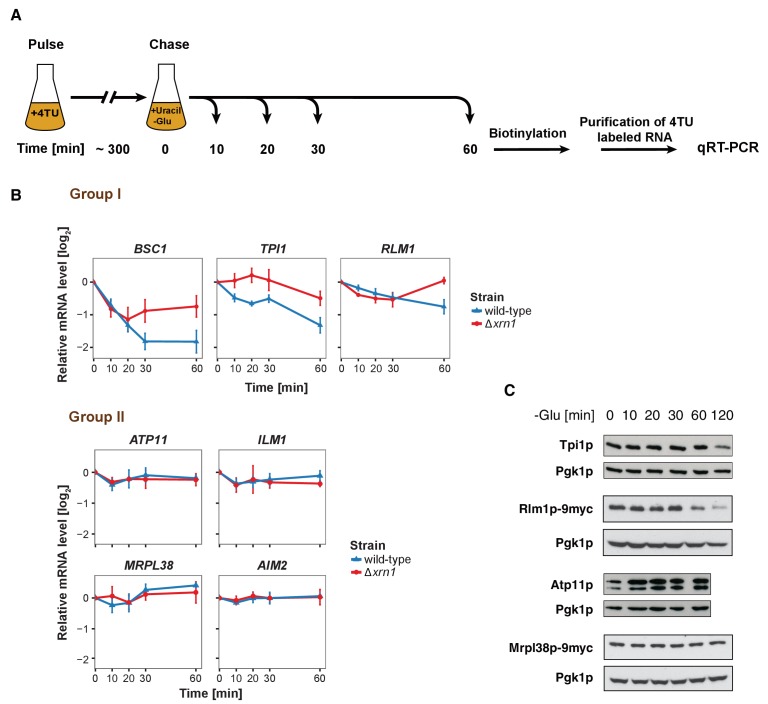
The stability of P-body associated mRNAs varies and can be categorized according to their GO terms.(A) Schematic illustration of pulse-chase protocol. Cells were grown in the presence of 0.2 mM 4-TU and shifted into media lacking glucose but containing 20 mM uracil. Cells were harvested at indicated time points after the shift. Total RNA was extracted and biotinylated. 4TU labeled RNA was purified and subsequently analyzed by qRT-PCR. (B) The stability of 4TU labeled candidate mRNAs was determined by qRT-PCR in wild type and Δxrn1 strains at indicated time points following a shift to glucose-depleted media. Transcription levels were normalized using ACT1 gene as an endogenous reference. Group I: non-mitochondria-related candidates. Group II: mitochondria-related candidates. Error bars, mean ±SEM. (C) Western blot analysis of Tpi1p, Rlm1p-9myc, Atp11p and Mprl38p-9myc at indicated time points after glucose deprivation. The 9myc tag was inserted at the end of the coding sequence without affecting the 3’UTR. Pgk1p was used as a loading control. Anti-Tpi1p, anti-Atp11p, anti-myc and anti-Pgk1p were used for detection. Results are representative of 3–4 independent experiments per target protein.10.7554/eLife.29815.013Figure 3—source data 1.Data used for plotting.Files contains data for panel B of Figure 3.